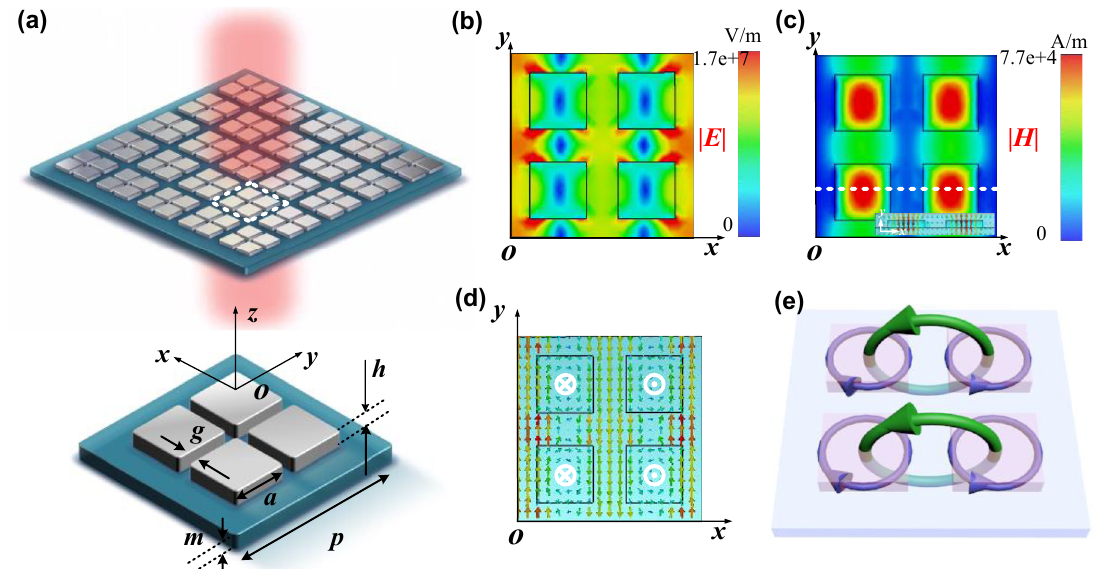
Figure 1: Schematic diagram of the proposed symmetric metasurface. (a) 3D schematic diagram of the symmetric metasurface, where p = 6.2, m = 0.36, g = 1.1, a = 1.9, h = 0.3 μ m. (b) Electric field profile in x – y mid-plane. (c) Magnetic field profile in x – y plane and